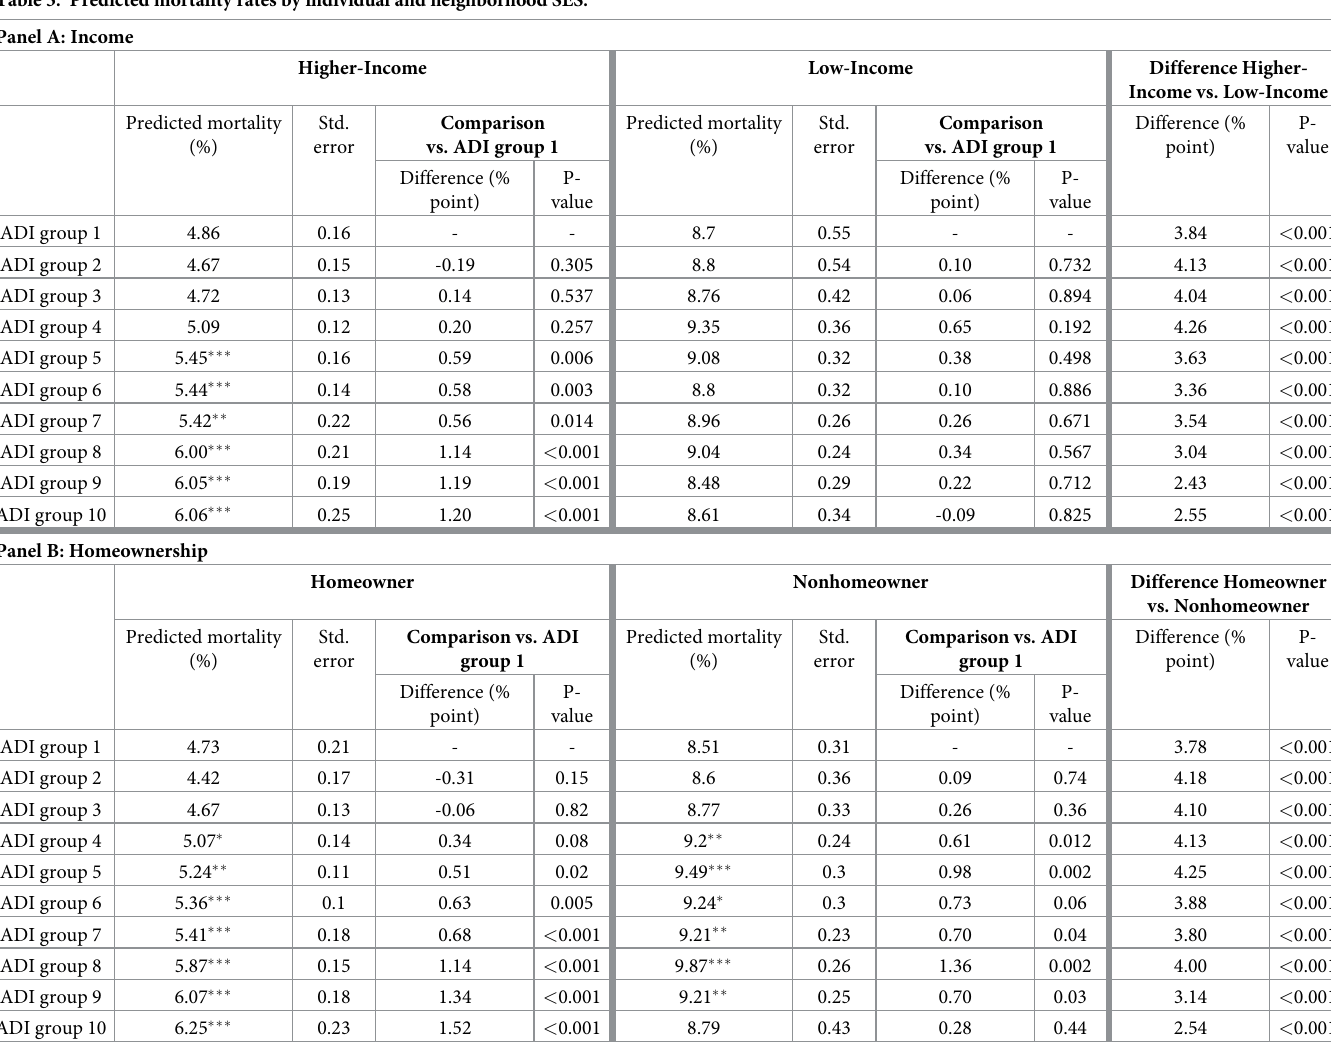
Table 3. Predicted mortality rates by individual and neighborhood SES. Panel A: Income Higher-Income Low-Income Difference Higher- Predicted mortality Comparison (%) vs. ADI group 1